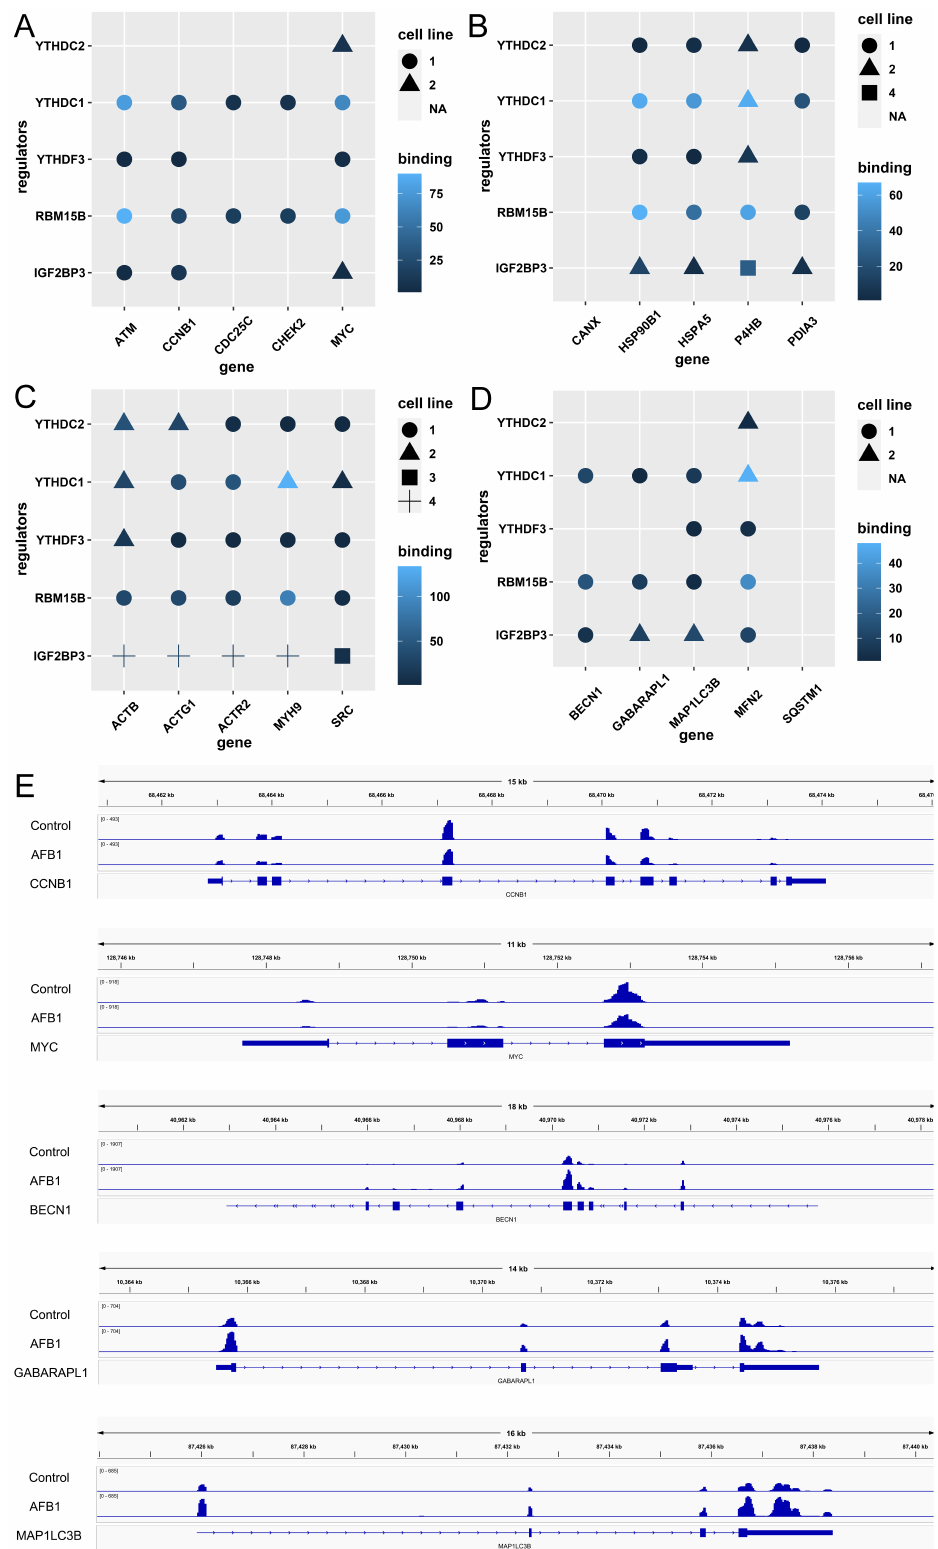
Figure 9. The substrates of m6A regulators: ( A ) cell cycle, ( B ) ER, ( C ) tight junction, and ( D ) mi- tophagy pathways enriched in the KEGG analysis. The cell lines including HeLa, Huh7, HEK293, HepG2, Panc1, PL45, etc. were from the starBase v2.0. ( E ) depicts the levels of m6A methylation on CCNB1 , MYC , BECN1 , GABARAPL1 , and MAP1LC3B mRNA